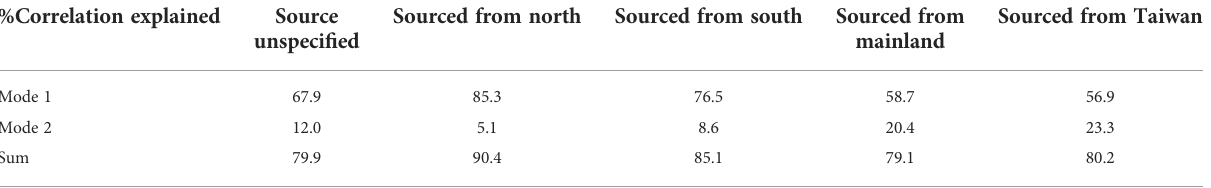
TABLE 1 The percentage explained by the fi rst two eigenmodes of each deviation fi eld. %Correlation